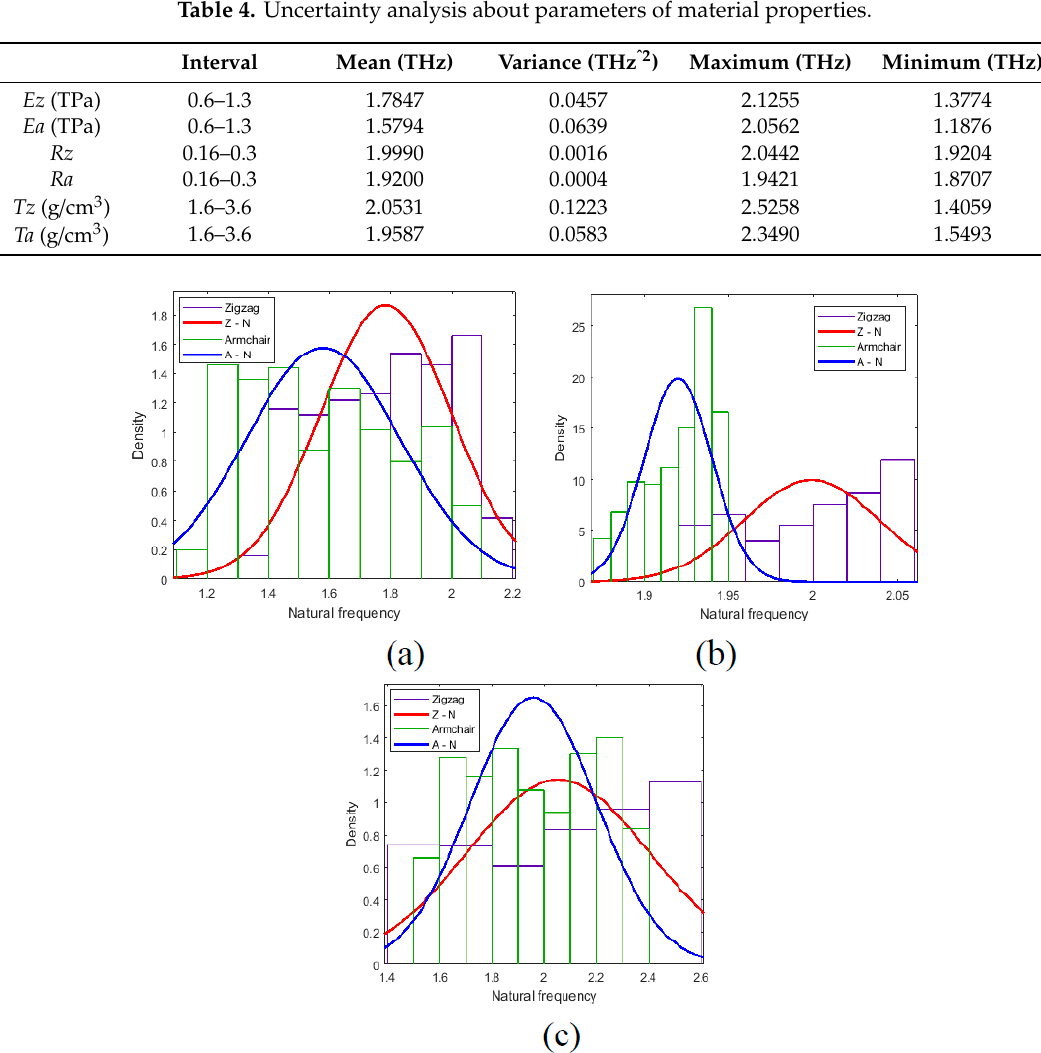
Figure 10. Probability density distribution of natural frequency for uncertainty analysis ( a ) is for Ez and Ea , ( b ) is for Rz and Ra , ( c ) is for Tz and Ta . The unit for the natural frequency is THz.